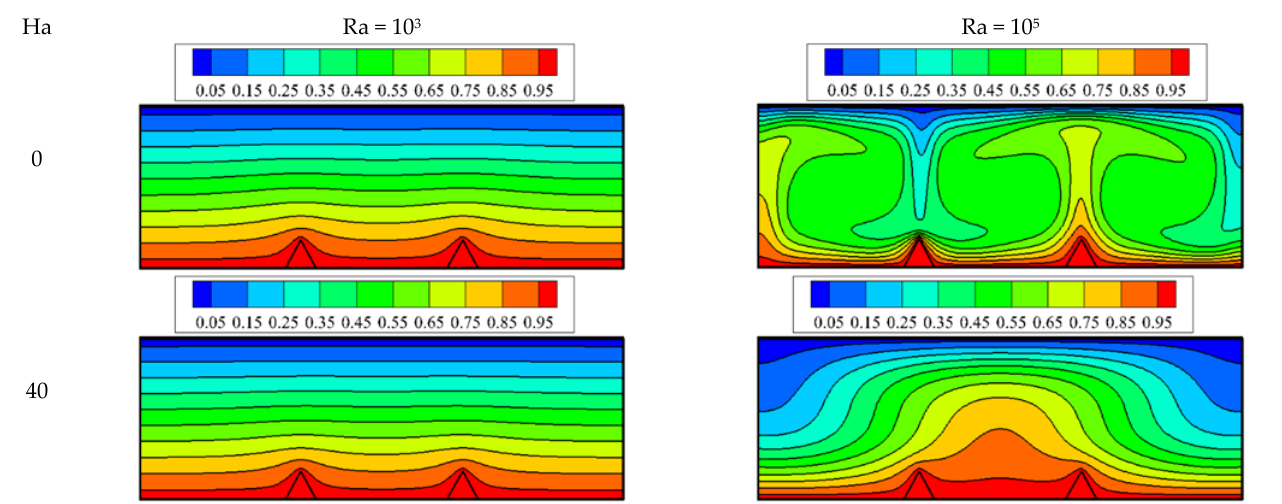
Figure 3. The effect of Ra and Ha on the velocity field for H = W = 0.2. Figure 4 reveals the effect of Ra and Ha on the temperature field for H = W = 0.2 and a volume fraction of 0.3%. In the case of low Ra, the isotherms do not change with the Ha and remain as parallel lines. However, for Ra = 10 5 , the variations of the Ha affect the isotherms and change their shape. The changes of the Ra also affect the temperature con- tours, changing it from parallel lines to overlapping ones.